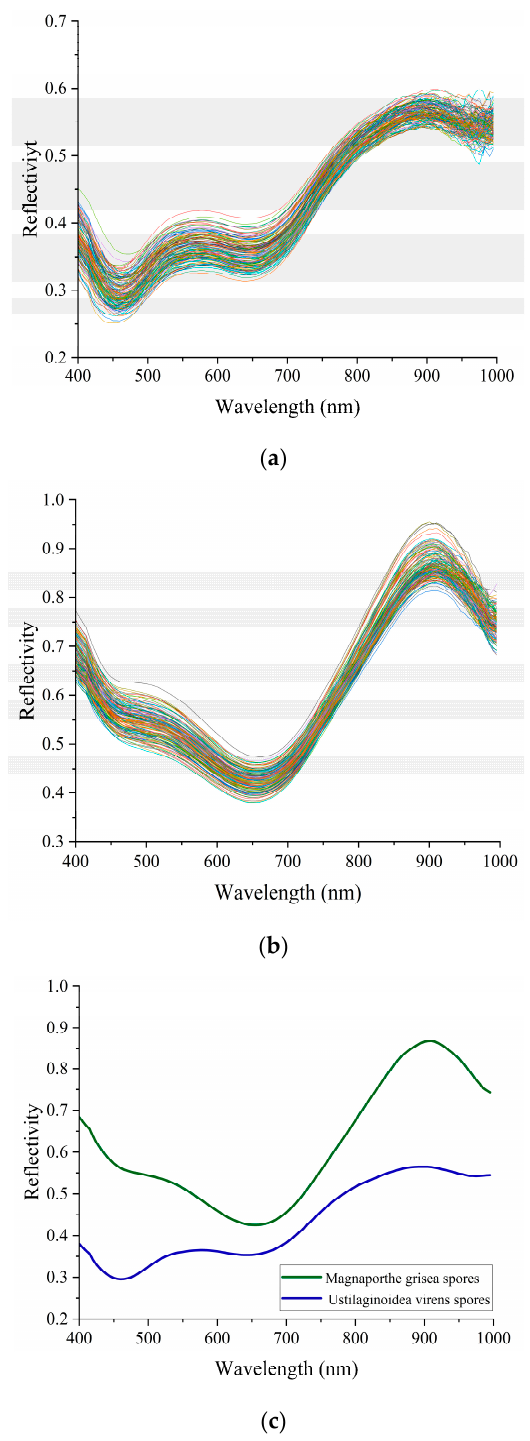
Figure 8. ( a ) is the original spectrum of Magnaporthe grisea spores. It can be roughly known that there are obvious troughs at the wavelength of 400 nm and 650 nm, and there are peaks at the wavelength of 550 nm and 900 nm; ( b ) is the original spectrum of Ustilaginoidea virens spores. We can see that there are wave troughs and peaks at the wavelengths of 650 nm and 900 nm, and the reflectivity rises sharply from the wave troughs, and basically rises to the highest point near 900 nm, forming a high reflection point. The rising speed and reflectivity intensity in this range are higher than that of rice aspergillosis spores; ( c ) is the average spectrum of spores.